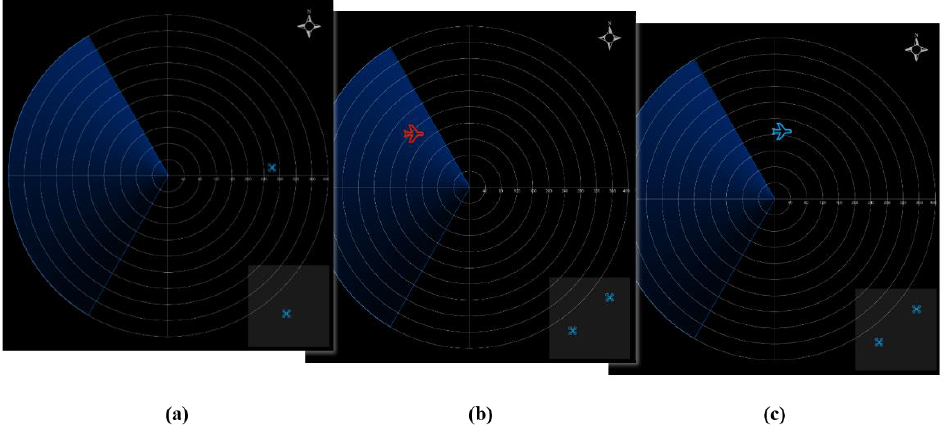
Figure 2. Simulated radar-scanning interface and UAV monitoring interface with ( a ) the appearance of enemy aircraft, ( b ) appearance of our own aircraft, and ( c ) UAV flying out of the designated box range.